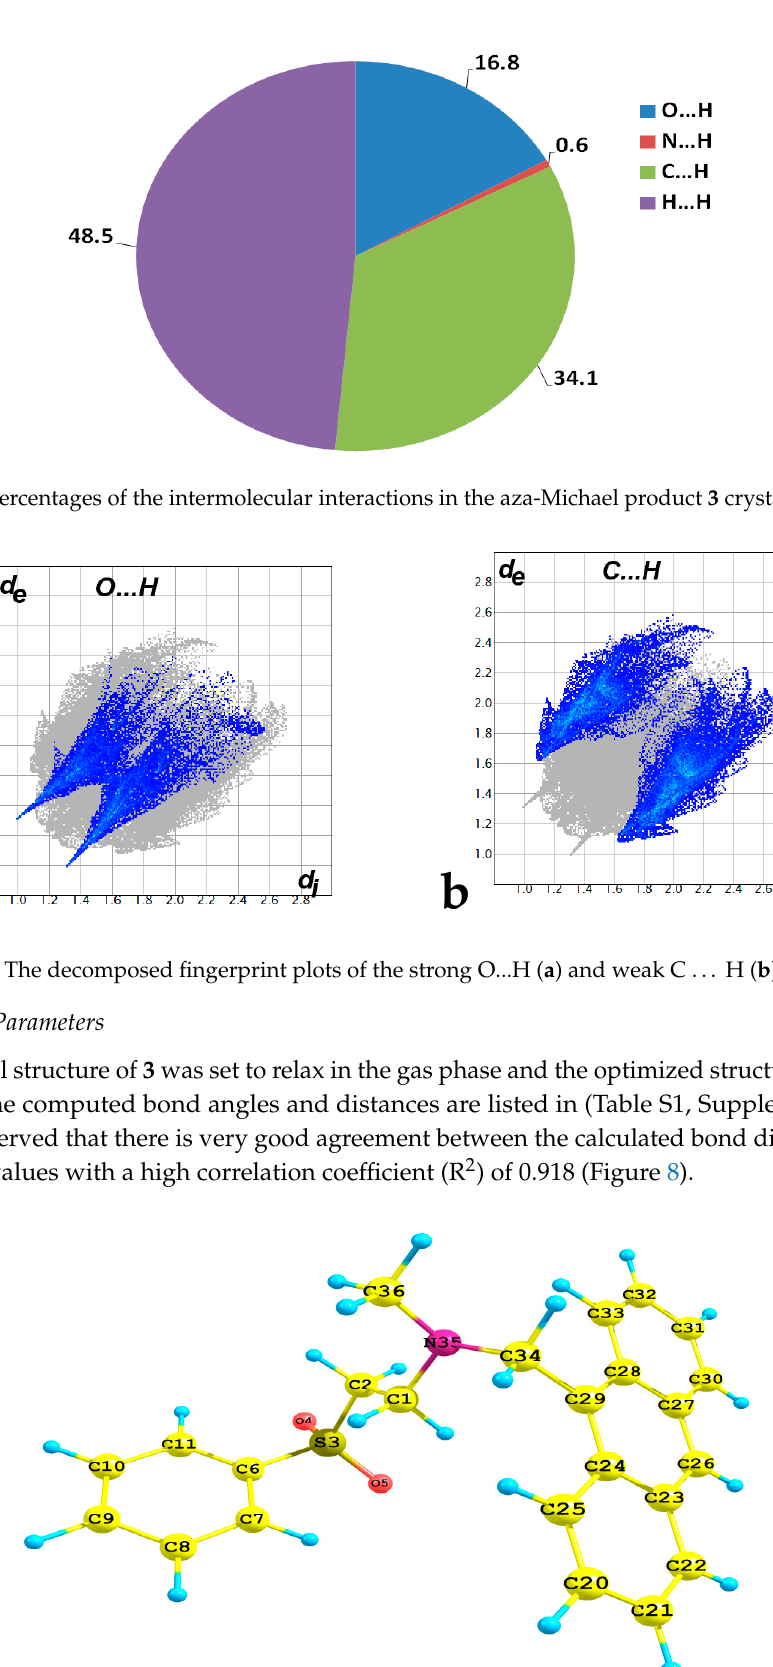
Figure 4. Hirshfeld surfaces mapped over d norm , curvedness and shape index for aza-Michael product 3 . Regions A and B in the d norm maps refer to the strong and weak O…H and C…H contacts, respectively.